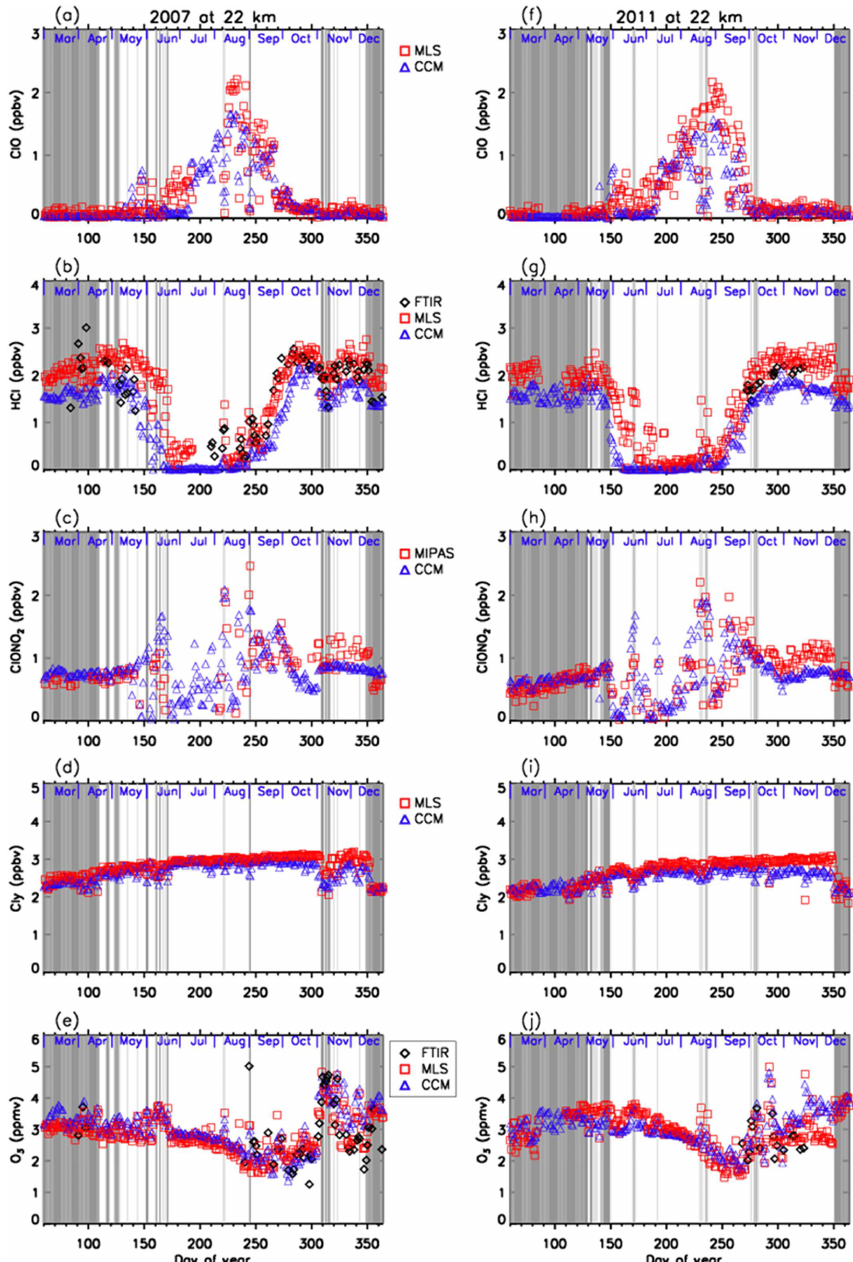
Figure 12. Same as Fig. 11 but for